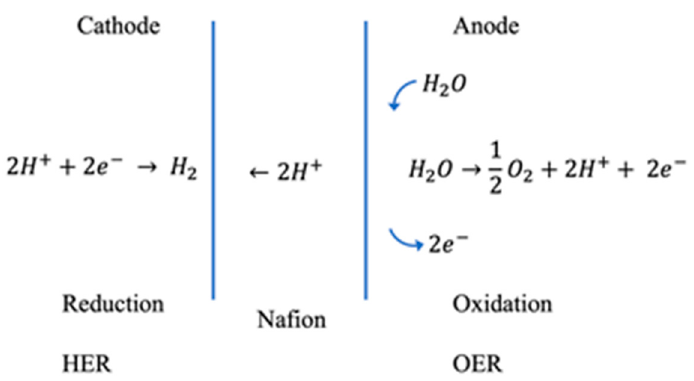
Figure 8. Schematic of PEM electrolyzer assembly and process. The creation of the H + occurs on the anode side of the PEM electrolyzer.